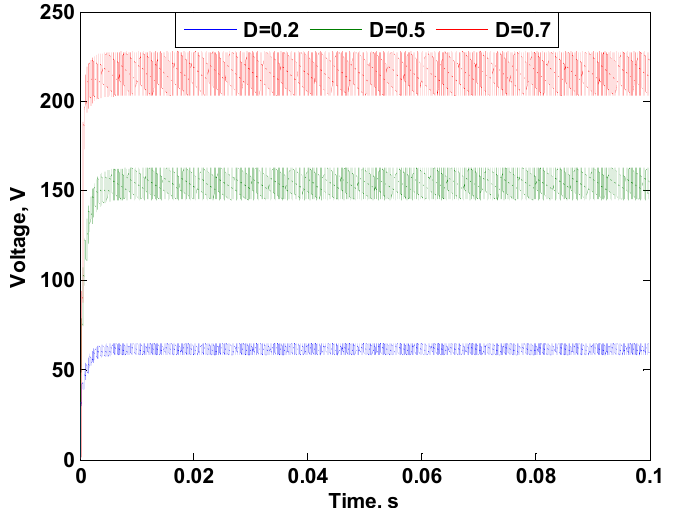
Figure 31. Output voltage at the output terminals of the modified converter at different duty ratios.